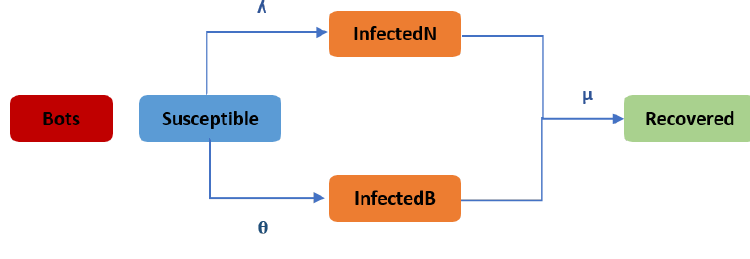
Figure 1. SI h I b R Rumor Diffusion